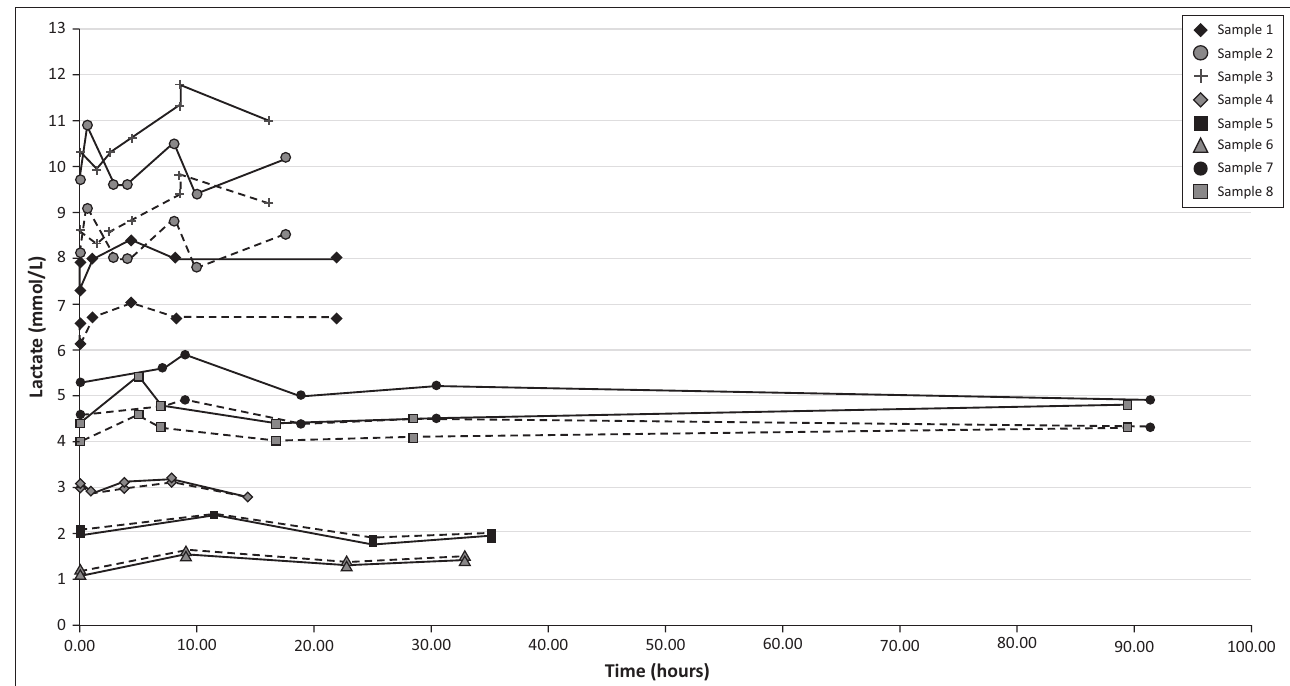
FIGURE 2: Lactate stability in sodium fluoride/potassium oxalate over time. The graph illustrates the measured concentration of lactate in 8 rhino blood samples (each sample designated by a shape marker) with sodium fluoride/potassium oxalate over time using the Accutrend meter set in either blood (BL, dashed line) or plasma (PL, solid line) TABLE 3: Stability of rhino blood lactate in sodium fluoride/potassium oxalate over time. Maximum change in blood lactate from Change in blood lactate from baseline at time 0, to last baseline over time measurement